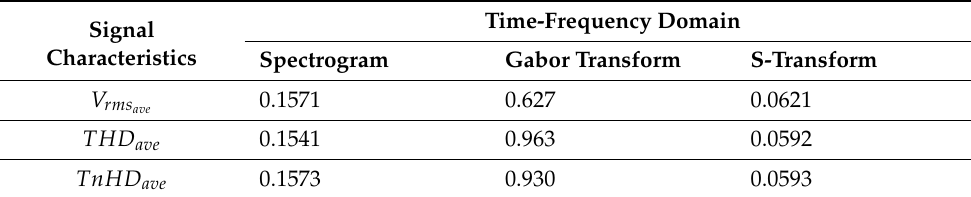
Table 2. The MAPE of the accuracy of the analysis.